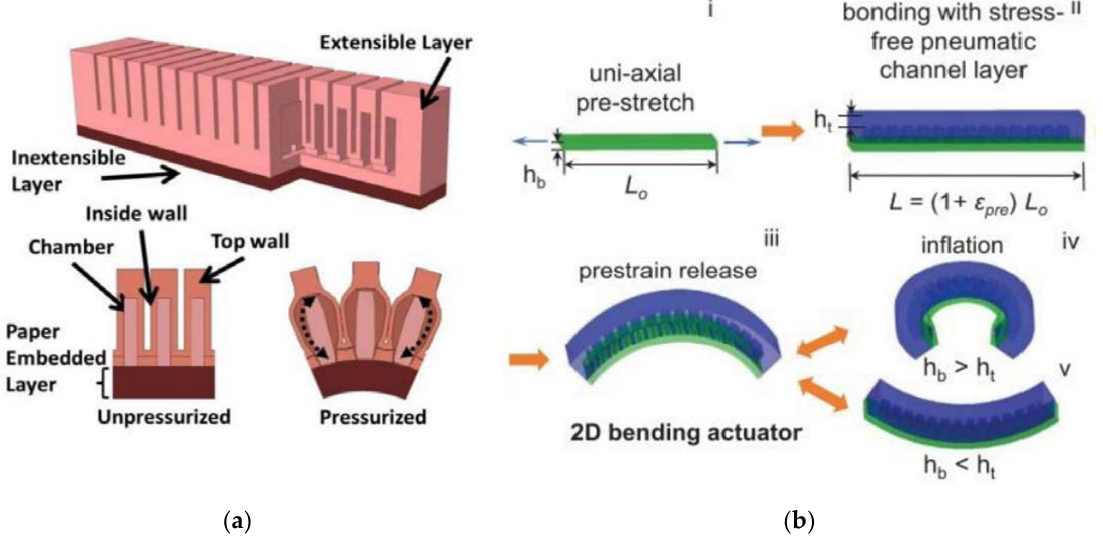
Figure 2. Pneu-Net actuator: ( a ) structural diagram of an optimised FEA [70] , reproduced with per- mission from [70] , 2014, John Wiley and Sons; ( b ) bistable precurved soft actuator [74] , reproduced with permission from [74] , 2020, John Wiley and